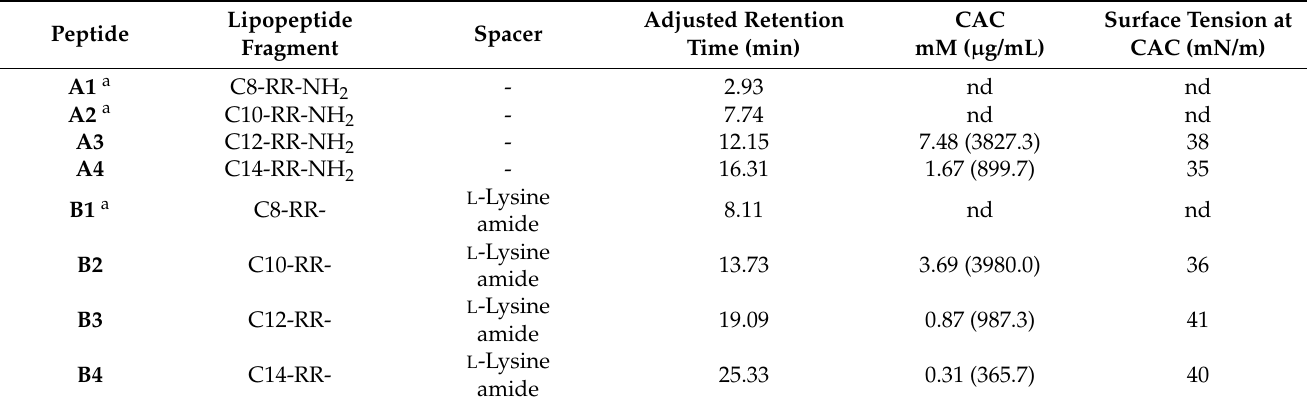
Table 1. Table 1. Physico-chemical properties of lipopeptides. Table 1. Physico-chemical properties of